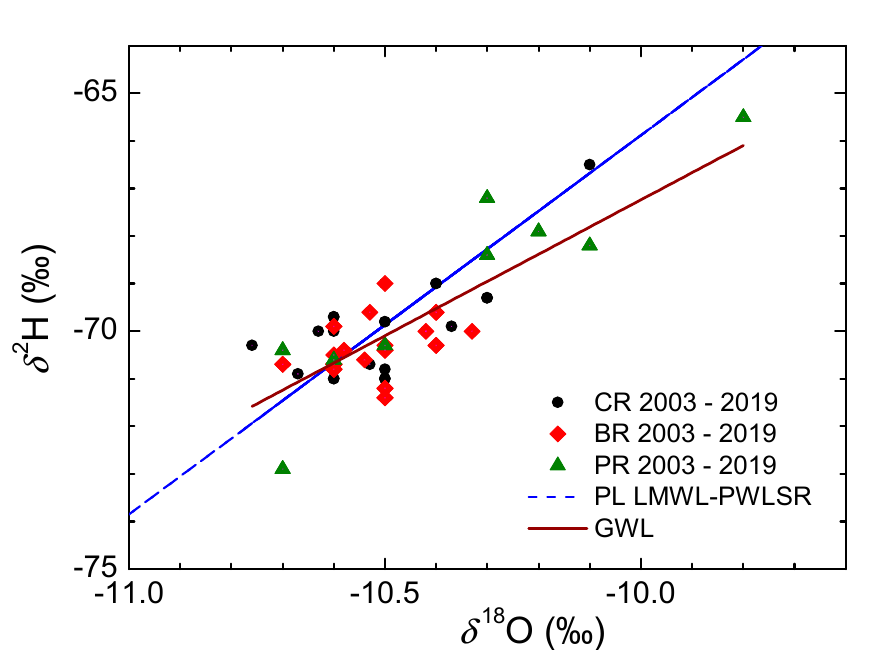
Table 4. Values of the slopes ( a ± σ a ) and intercepts ( b ± σ b ) for the groundwater line (GWL), surface water lines (SWL), and lake water lines (LWL).